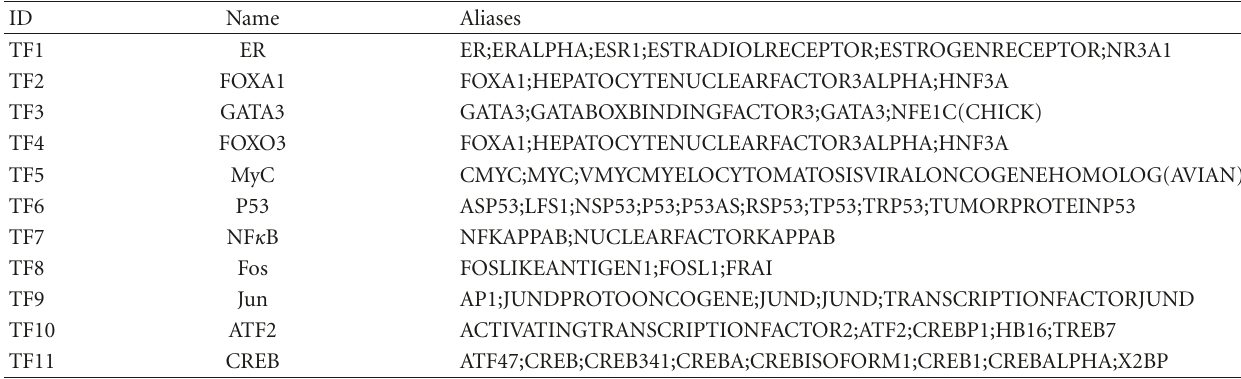
Table 3: Transcription factor